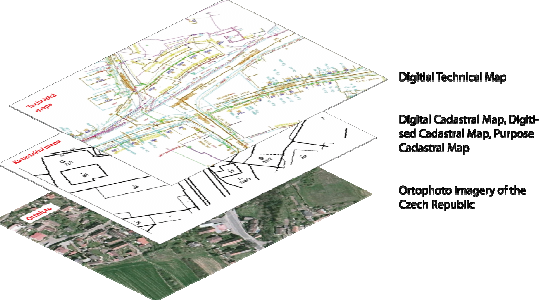
Figure 2. Digial Map of Public Administration (DMVS) and its components. (Source: